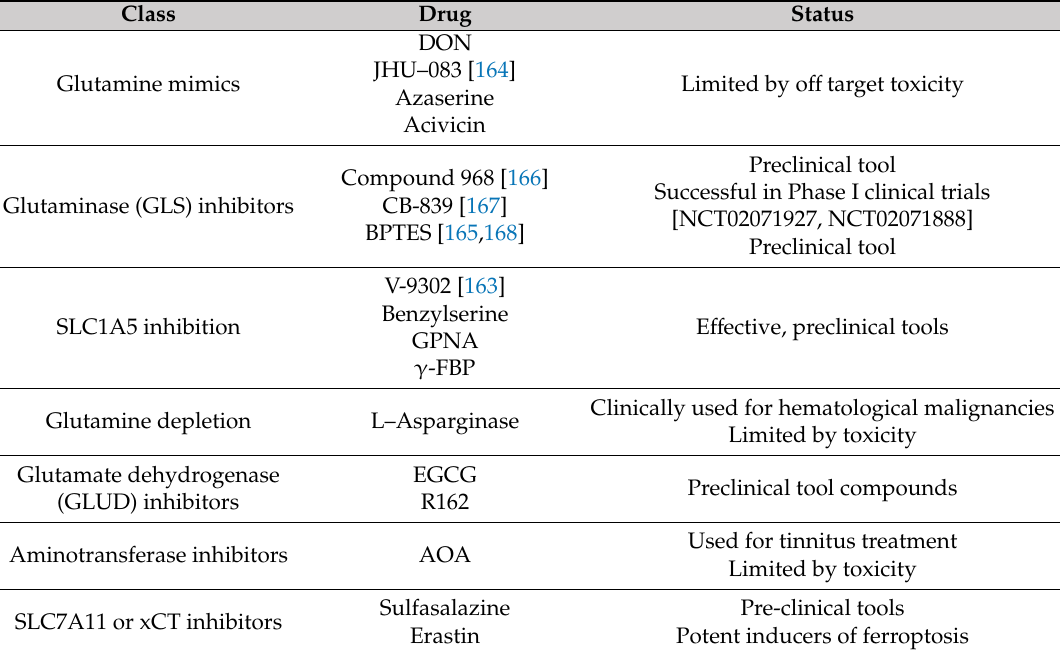
Table 1. Therapeutic strategies targeting glutamine metabolism in tumors. Class